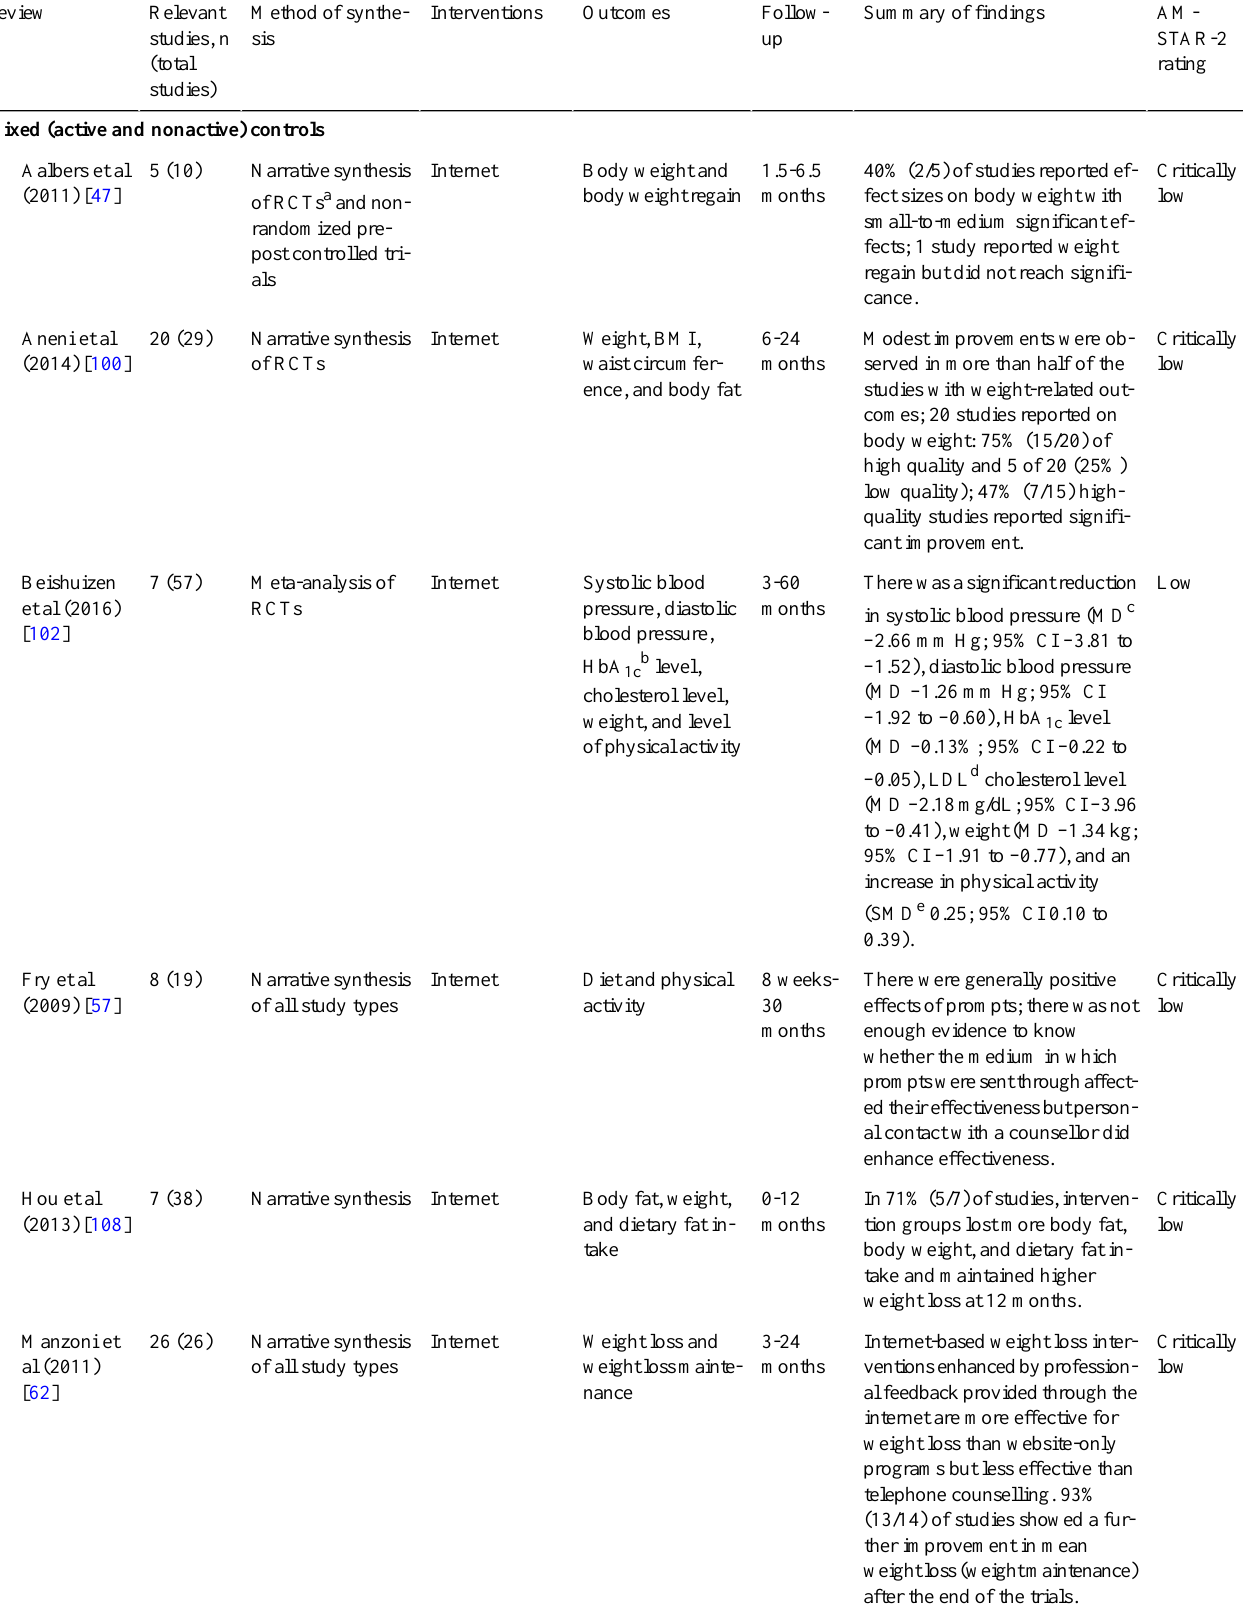
Table 5. Results of reviews on diet and physical activity combined, ordered by type of control and further ordered by mode of delivery of intervention.